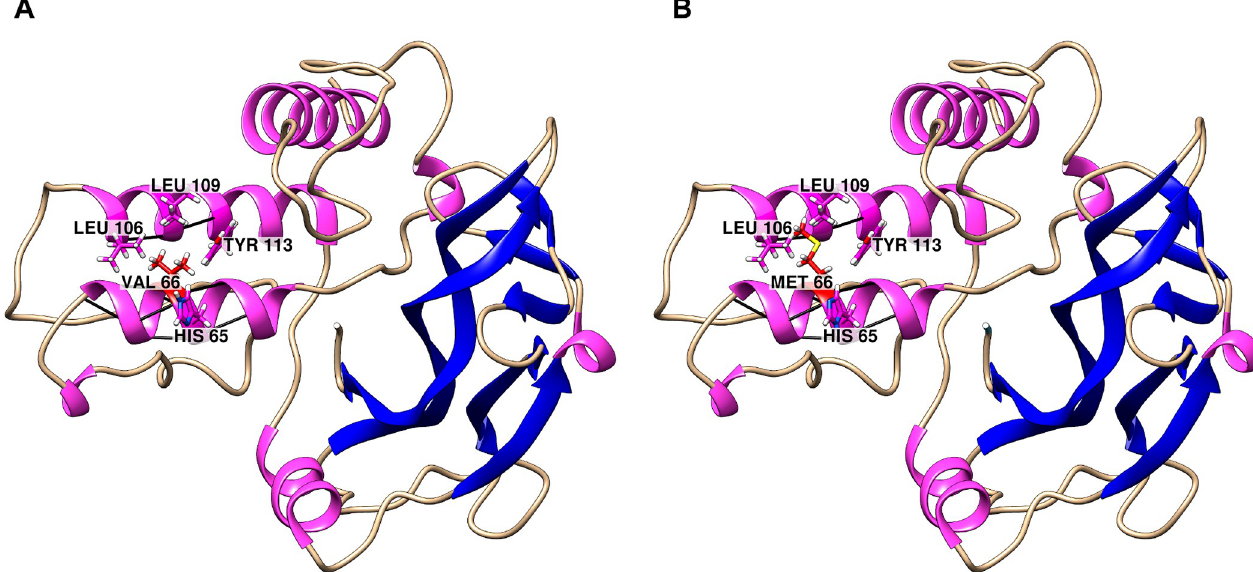
Fig 7. Complete theoretical models of wild-type BDNF and its variant V66M. Secondary structure representation of the in silico modeled structures of wild- type BDNF and its variant V66M. The α -helices are represented by pink ribbons, the β -strands are represented by blue arrows, and the coiled regions are represented in beige. Residues within 5 Å of val66 and met66 are shown in the sticks. Black lines represent hydrogen bonds. (A) Wild-type BDNF. (B) Variant V66M.